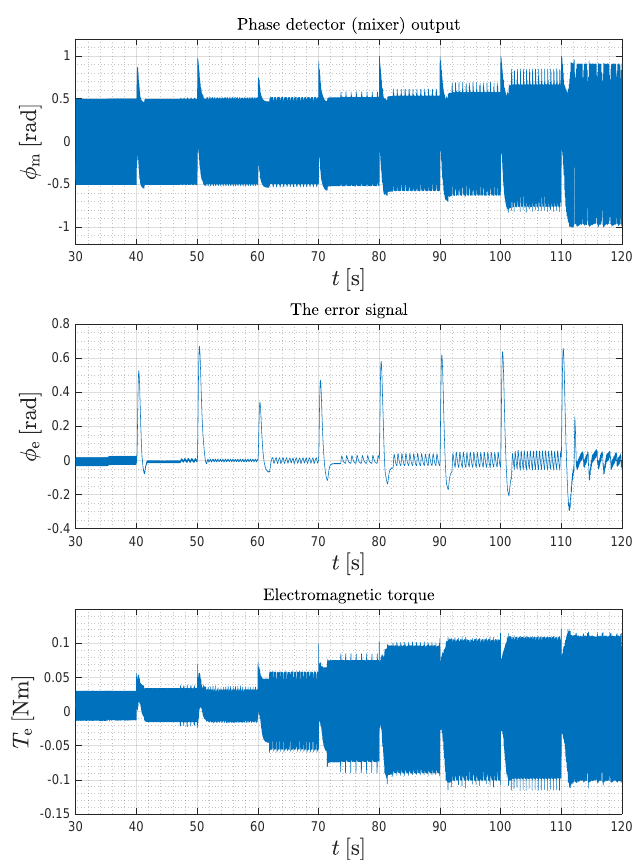
Figure 22. Simulated step-up error response of the phase shift feedback